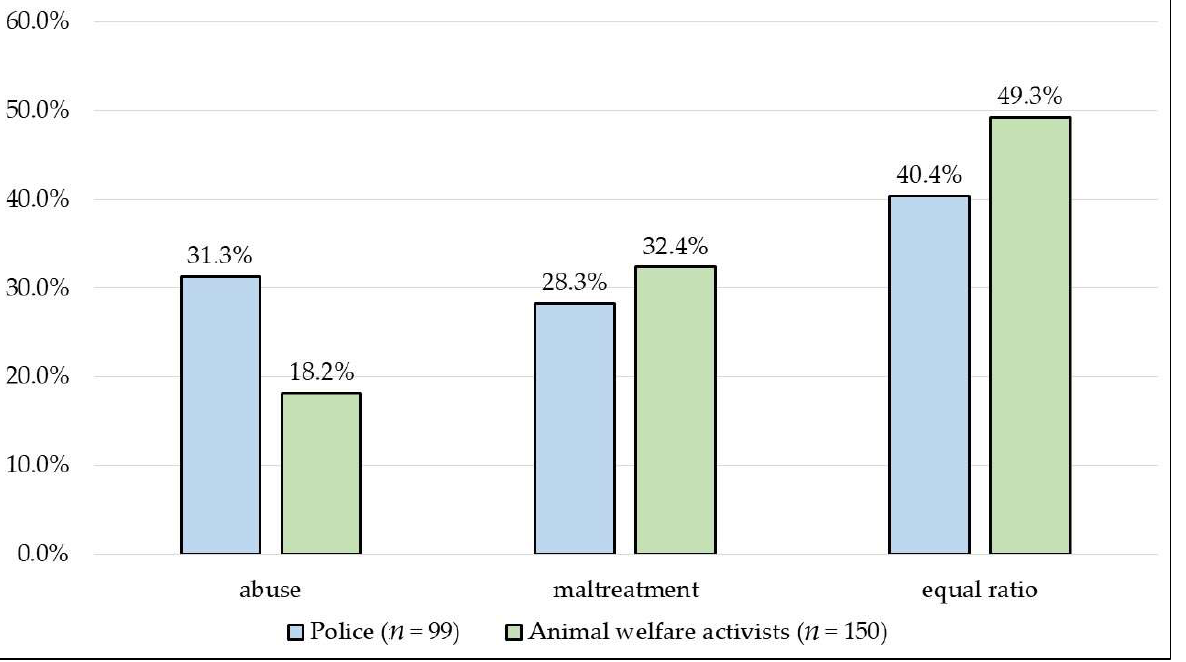
Figure 5. According to the police authorities, how difficult is it to investigate certain elements of the criminal law on animal cruelty? ( n = 99).